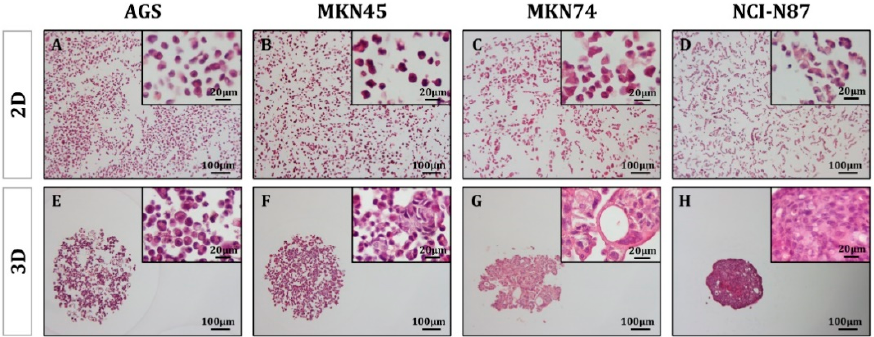
Figure 3. Gastric multicellular tumor spheroid histology. Hematoxylin and eosin staining of representative histological sections of gastric cancer cell lines grown in 2D ( A – D ) or 3D conditions ( E – H ).